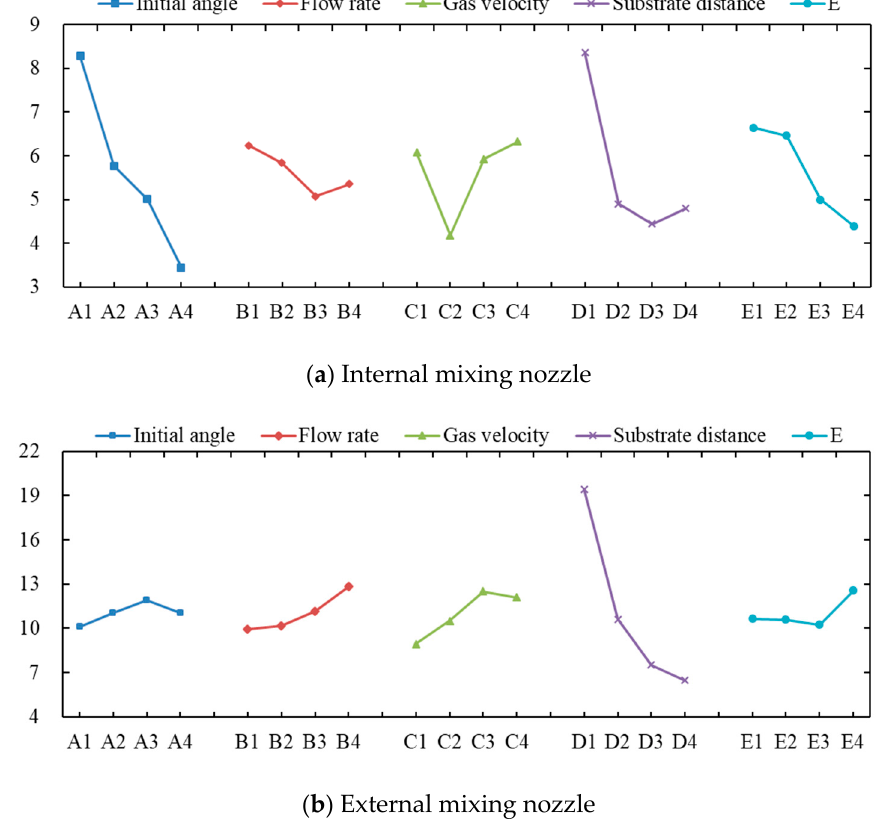
Figure 4. Profiles of uniformity of two nozzles for different factors.